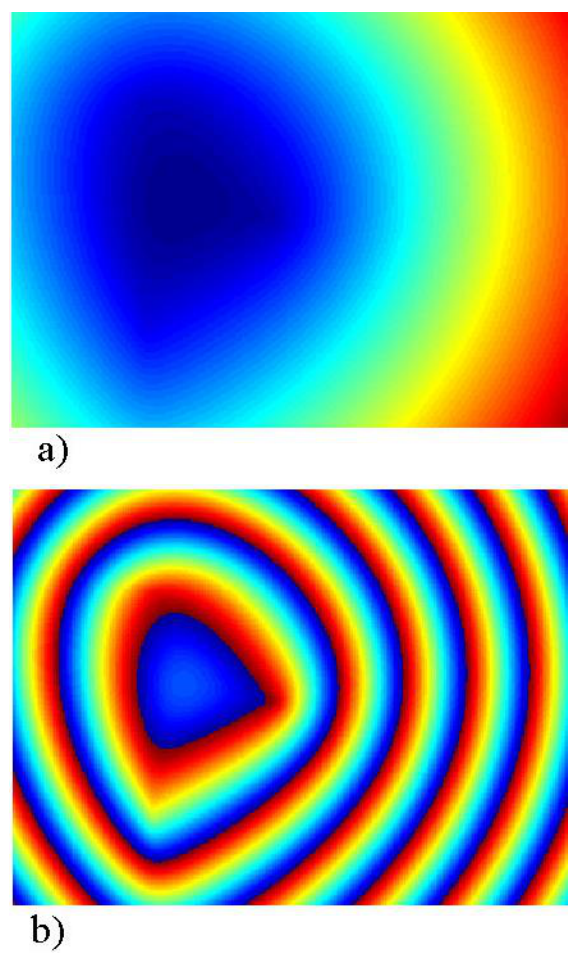
Figure 1. Simulated phases. a) True unambiguous interferogram. b) An interferogram of wrap phases